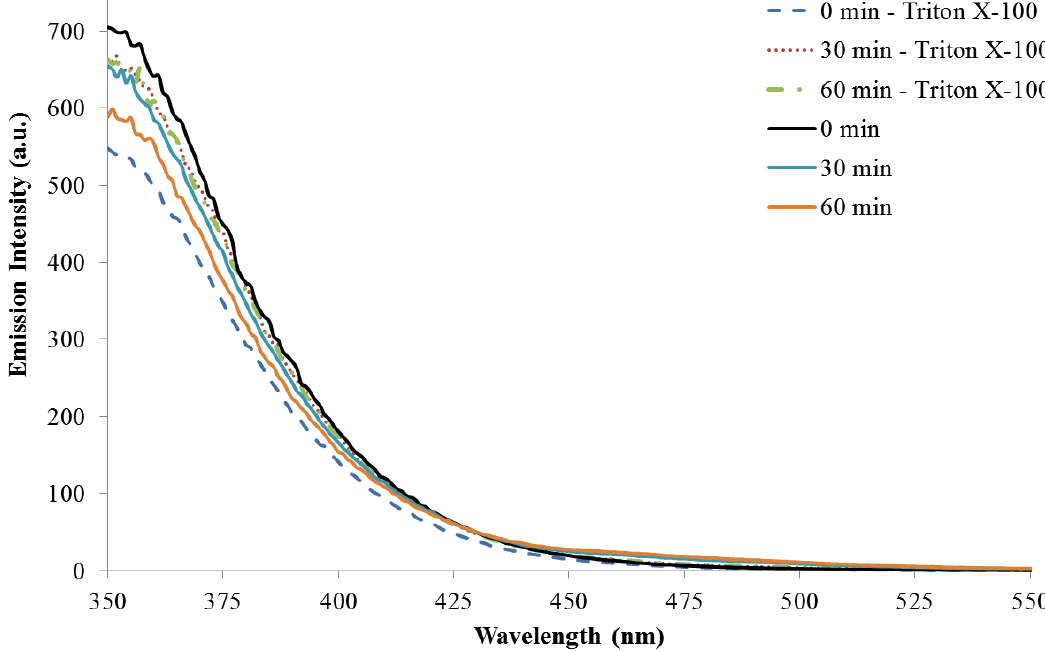
Photoluminescence Monitoring at Various Excitation Wavelengths Figure A5. Fluorescence emission (λ ex = 300 nm) as a function of reaction time with and without Triton X-100. Excitation at 300 nm corresponds to excitation of the indole